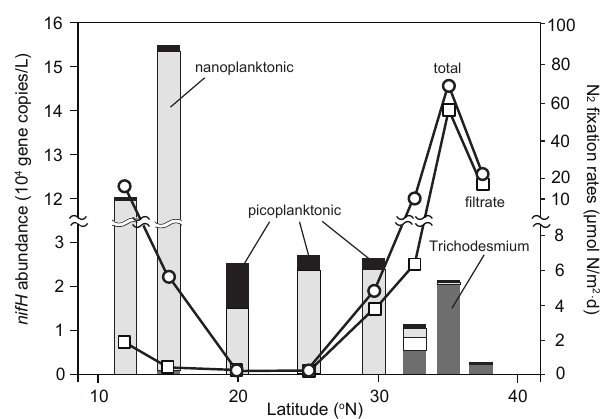
Fig. 4. Abundance of nifH gene copies (bar charts: left axis) and the N 2 fixation rates (line charts: right axis) during the KH08-2 expedition. The dark gray, white, light gray, and black bars de- note the results for Trichodesmium spp., heterocystous diazotroghs, nanoplanktonic diazotrophs, and picoplanktonic diazotrophs, re- spectively. The circles and squares on the line charts represent the total N 2 fixation rates (µmolNm − 2 d − 1 ) , and the rates in the filtrate fraction,